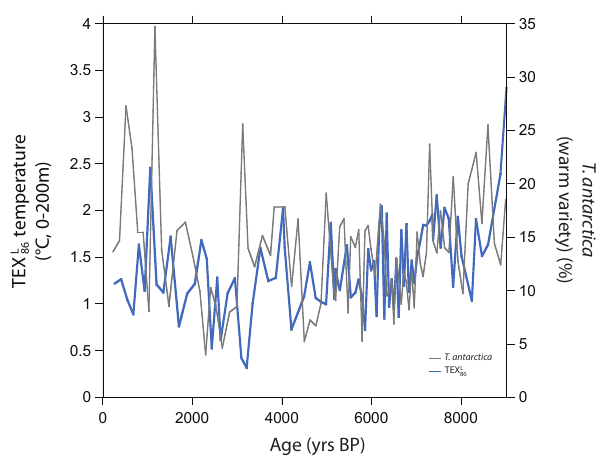
Fig. 7. Comparison between the JPC-10 TEX L and T. antarctica warm variety (%)